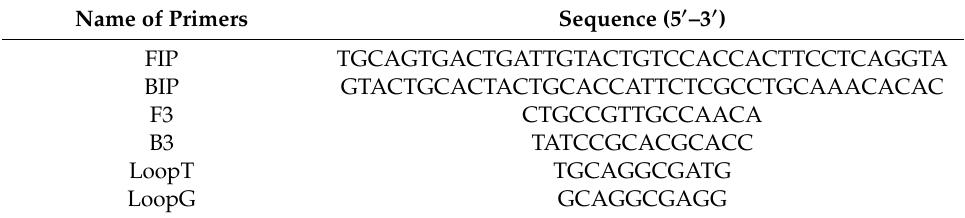
Table 1. Names and Primer sequences used in the